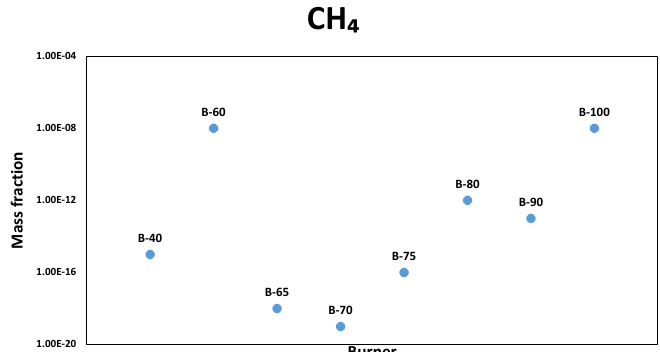
Figure 6. Methane mass fraction at the outlet of each burner calculated by the skeletal reaction